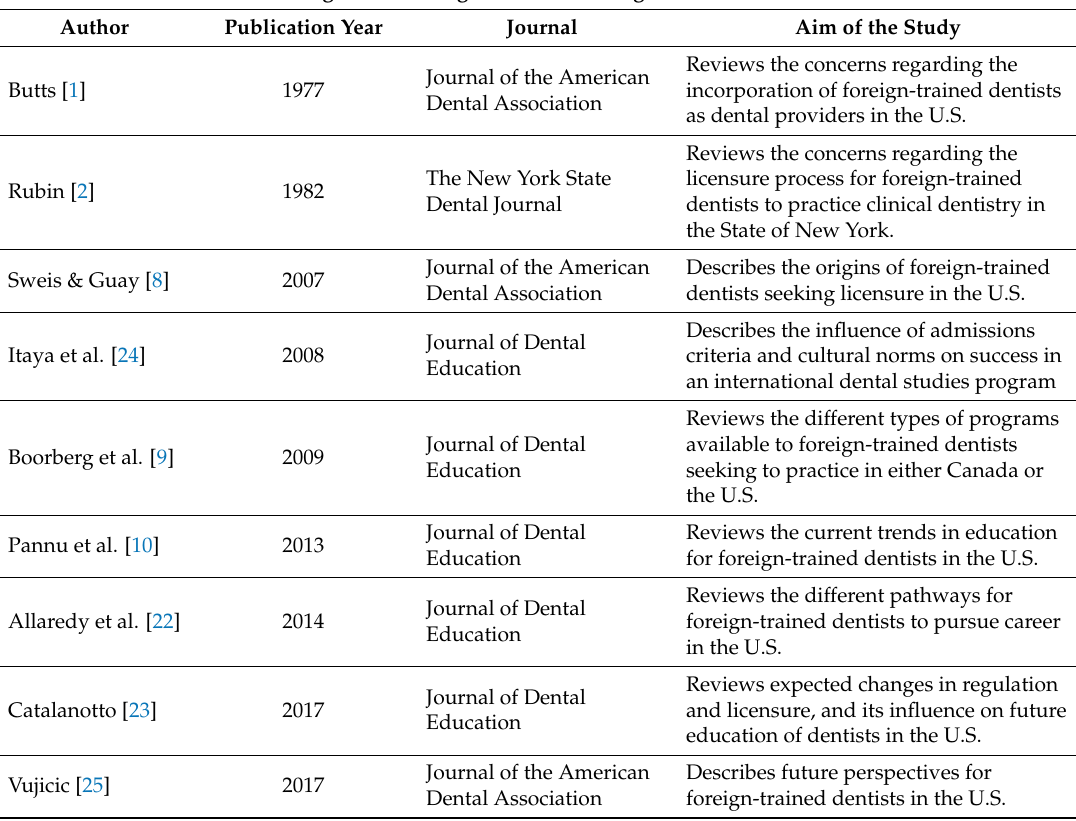
Table 2. Details of the reviewed articles discussing the licensing process for foreign-trained dentists in the U.S.